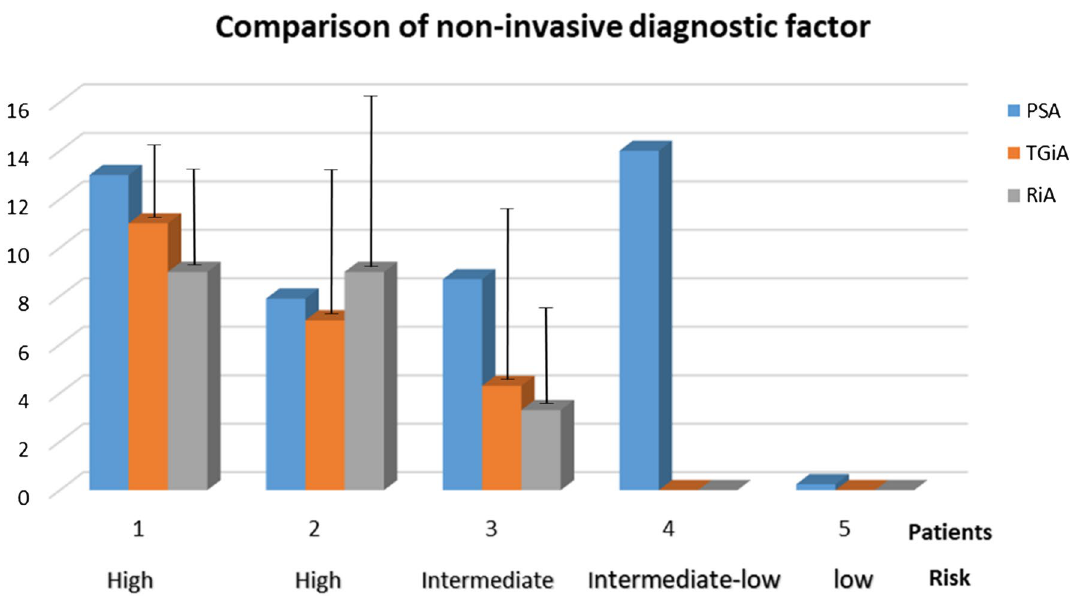
Figure 3. The reported PSA level (pathology result) and the numbers of PCa cells detected by TGiA and RiA assays (three replicates) in a small cohort of patients’ urine with different clinically determined